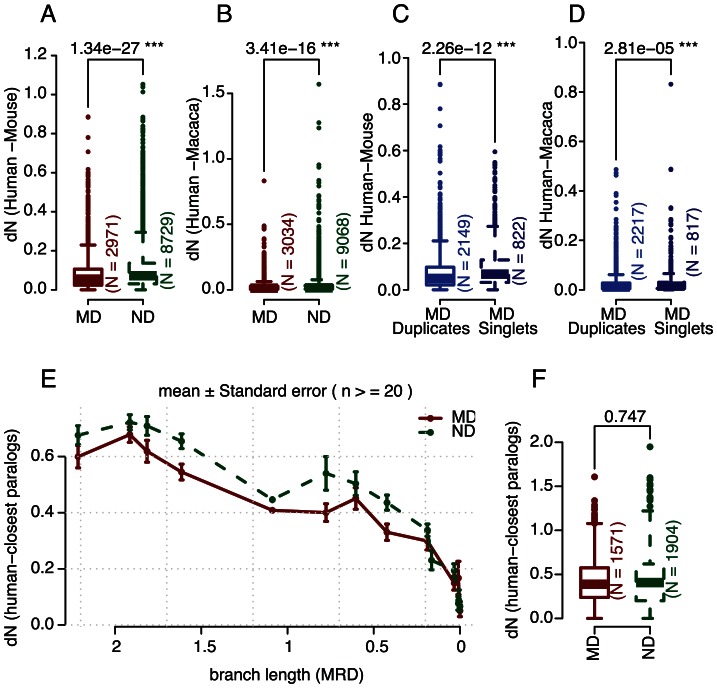
Higher purifying selections on duplicated disease genes.Compared with non-disease genes (NDs), disease genes tend to have lower dN values with their mouse- (A) and Macaca- (B) one-to-one orthologs. Furthermore, compared with disease singletons (singlet genes or singletons refer to those that do not share significant protein sequence similarities with other human genes), duplicated disease genes tend to have lower dN values with their mouse- (C) and Macaca- (D) orthologs. The higher selective constraints on duplicated disease genes can be also seen within the human genome; for example, compared with duplicated non-disease genes (ND) of similar duplication age, disease genes tend to have lower dN values with their closest paralogs within human (E; p-value = 4×10−7, Hypergeometric Distribution test). However the same isn't true when age is omitted (F), highlighting the importance of dividing gene pairs according to their duplication age. P-values shown in the boxplots (A∼D and F) were calculated using two-sample Wilcoxon Rank Sum Test. A similar plot showing no outliers is also available in Figure S6.